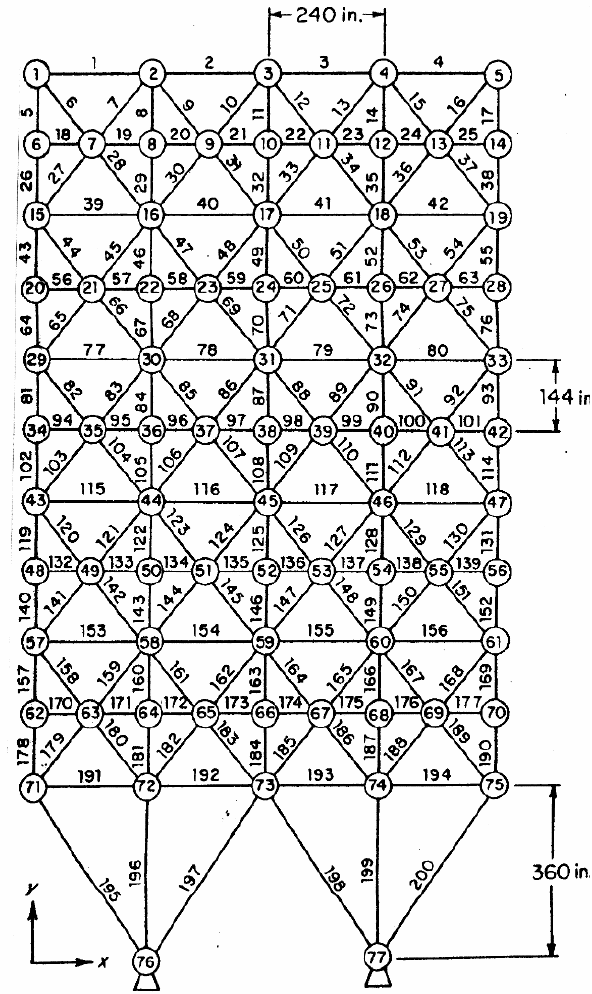
Figure 2. Schematic of the planar 200-bar truss structure. This test problem has 3500 non-linear constraints on nodal displacements and element stresses. The displacements of all free nodes in both coordinate directions X and Y must be less than ± 1.27 cm (i.e., ± 0.5 in). The allowable stress (the same in tension and com- pression) is 206.91 MPa (i.e., 30,000 psi). All non-linear constraints were independently evaluated, and no constraint grouping was adopted. The same was done for all test prob- lems considered in this study. Cross-sectional areas vary between 0.64516 cm 2 (i.e., 0.1 in 2 ) and 645.16 cm 2 (i.e., 100 in 2